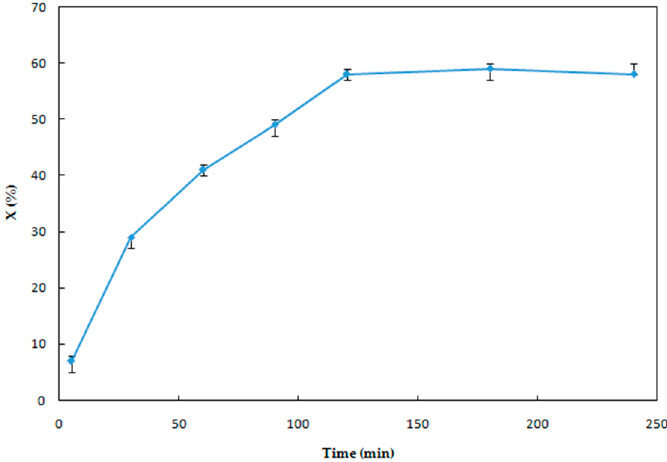
Figure 4. Effect of reaction time on the dissolution of LiCoO 2 .